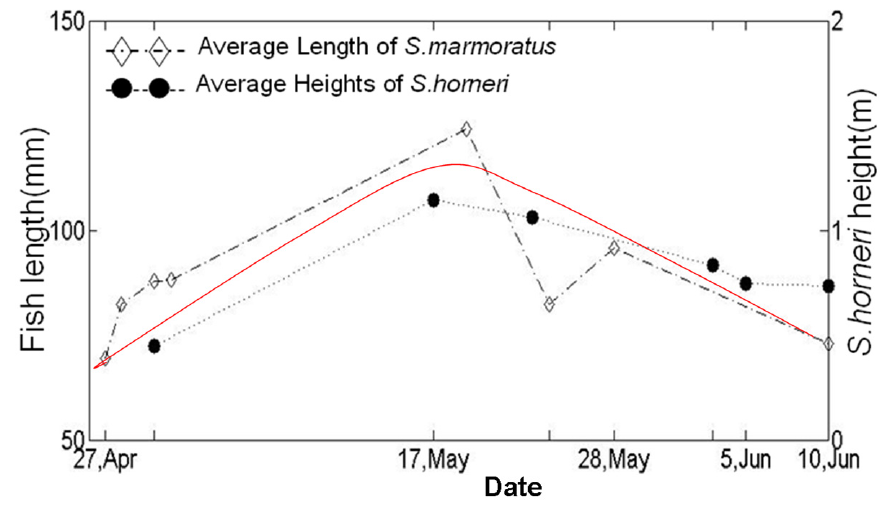
Figure 6. Relationship between Sebastiscus marmoratus average length (unit: mm) and Sargassum horneri thalli average height (unit: m) from 27 April to 10 June in 2010 in Houtouwan.